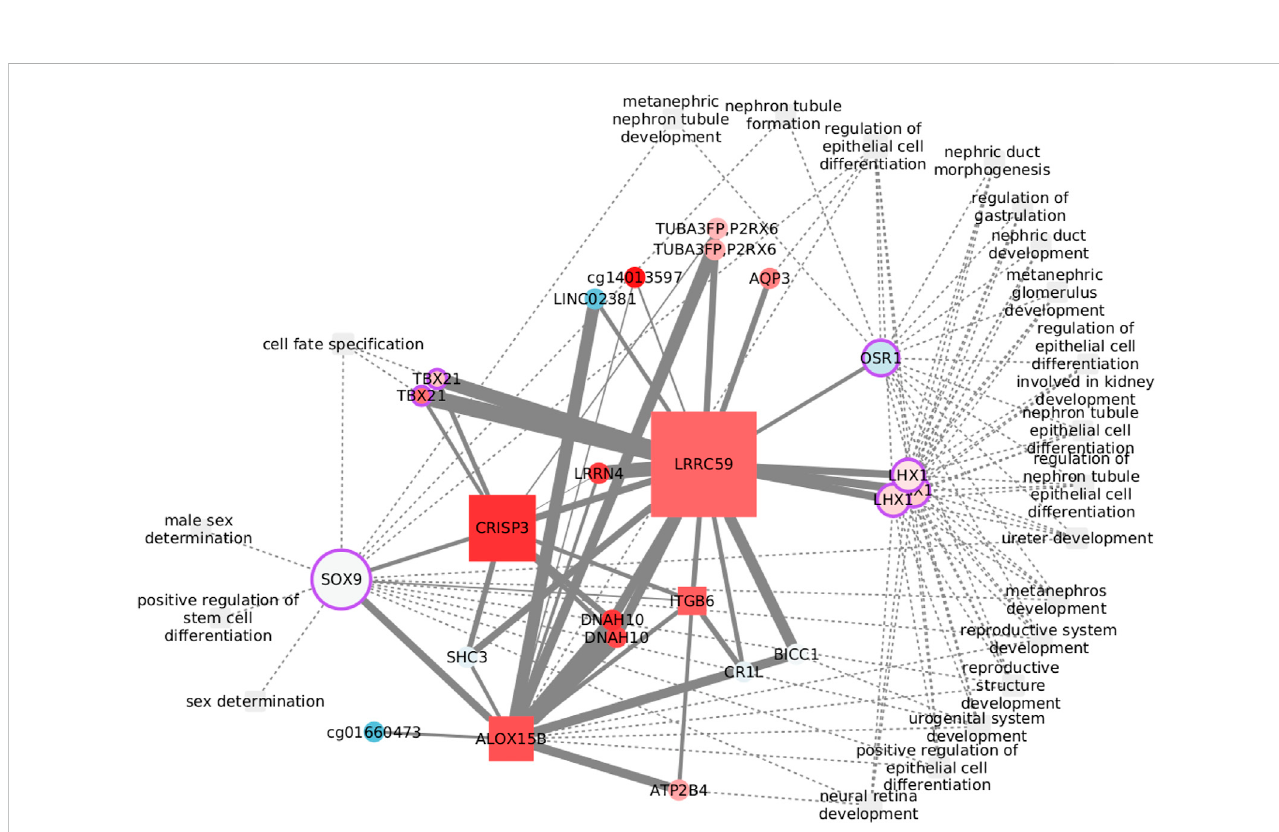
FIGURE 6 Features connected with the regulation of stem cell differentiation in the Her2-enriched subtype. Node size re fl ects the betweenness centrality.